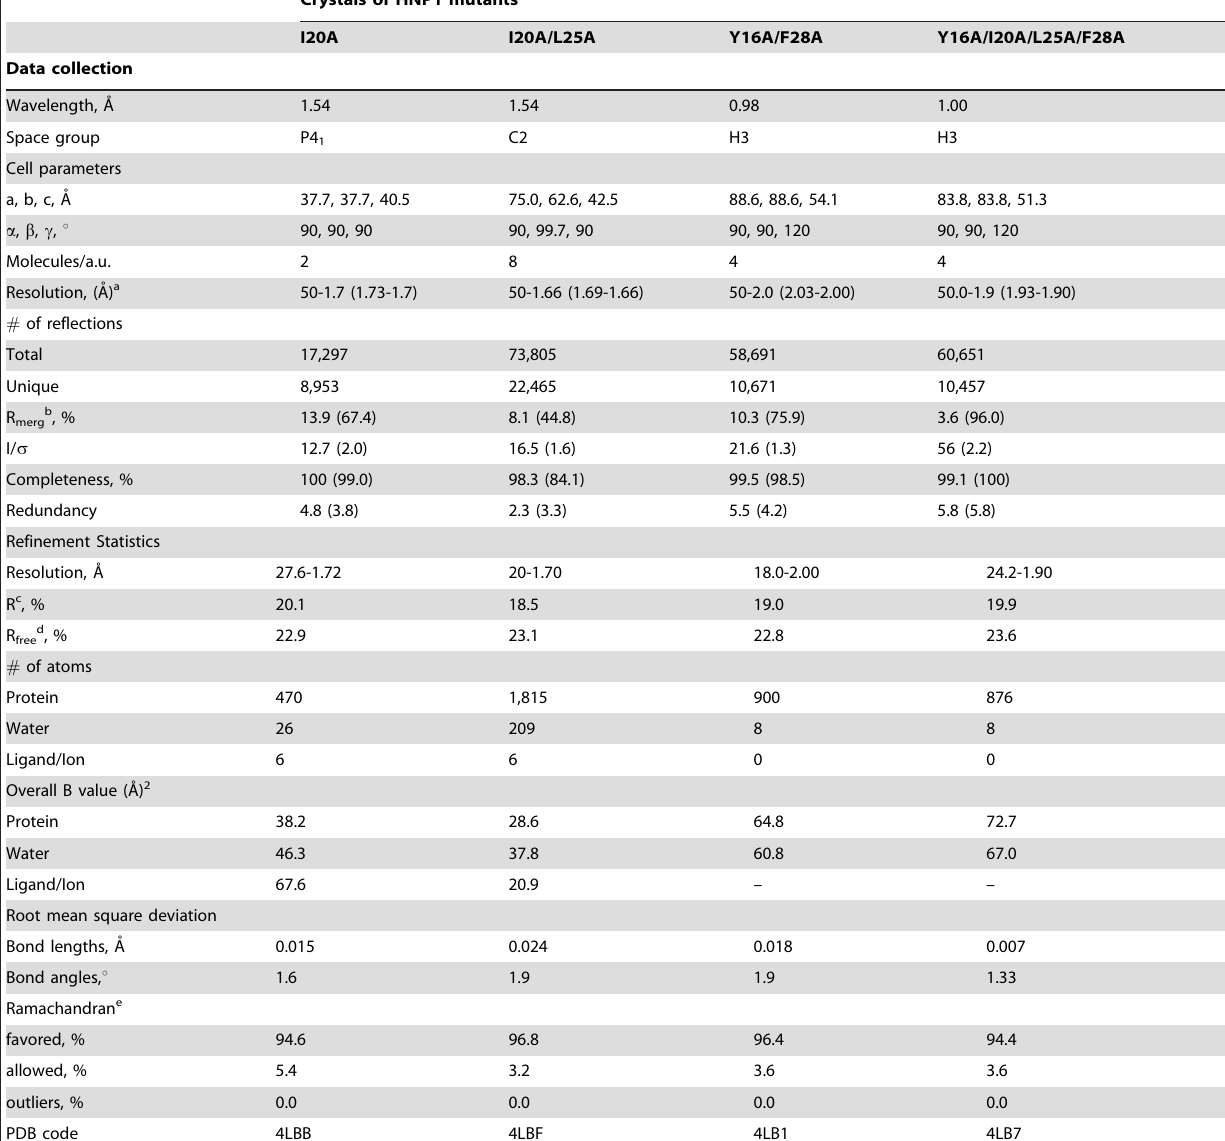
Table 2. Data collection and refinement